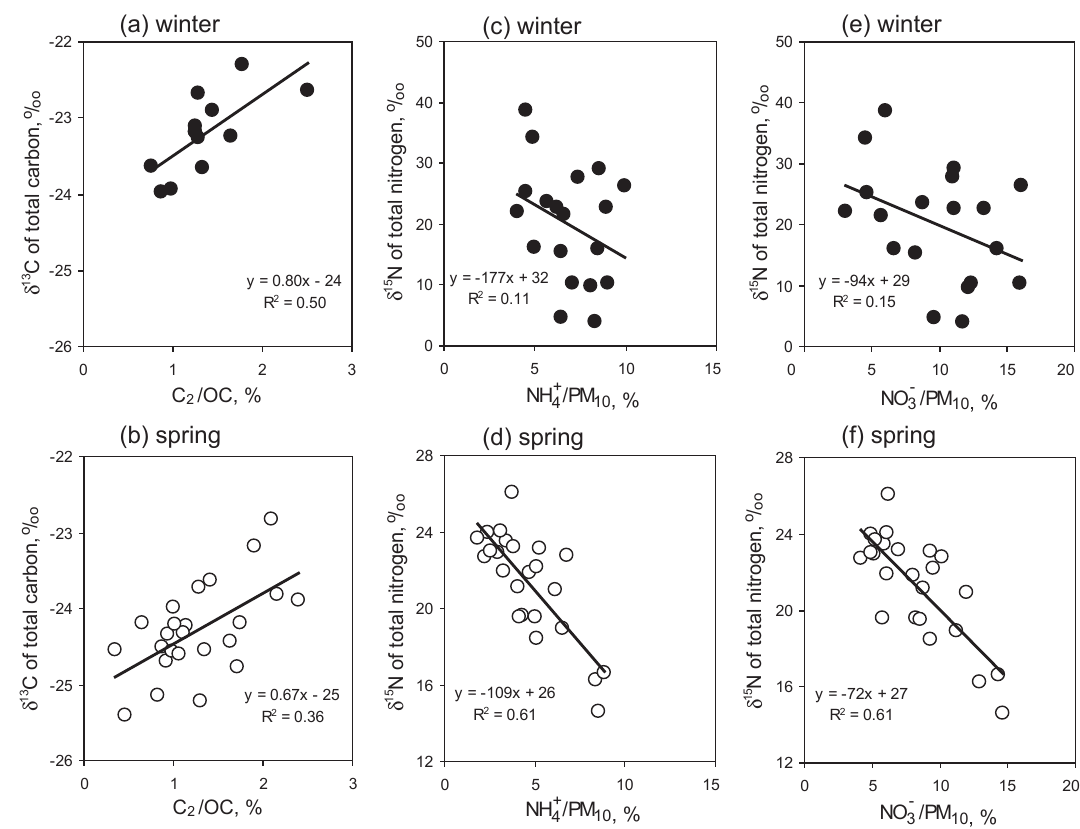
Fig. 8. Correlations of δ 13 C of TC with C 2 /OC ( a and b ) and δ 15 N of TN with NH + /PM 10 ( c and d ) and NO − /PM 10 ( e and f ) during winter 4 3 and spring (Data points including urban and suburban samples in each season. Due to instrument problem, the δ 13 C data for a few winter 13 Figure 8. Correlations of δ C of TC with C /OC ( a and b ) and samples are δ N of TN with NH /PM 10 ( c and d ) and NO /PM 10 ( e and f )